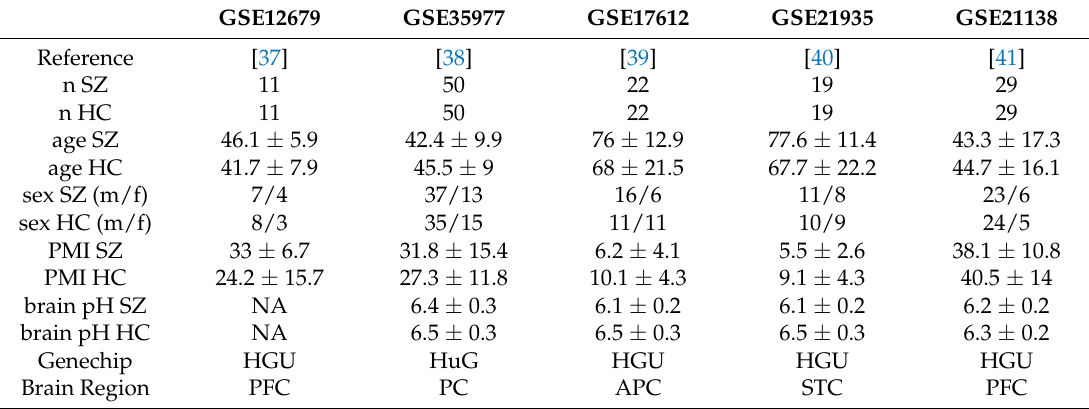
Table 2. Overview of demographic details. Values are shown as mean ±